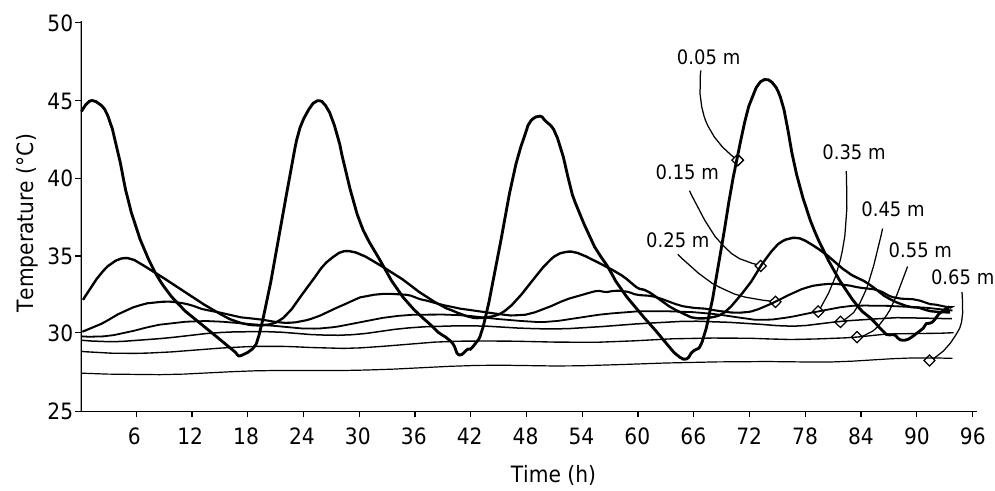
Figure 2. Temperature variation in soil at different depths with time, experiment from April 15-19, 2013 at the Universidad Veracruzana Campus Coatzacoalcos, Veracruz, Mexico.